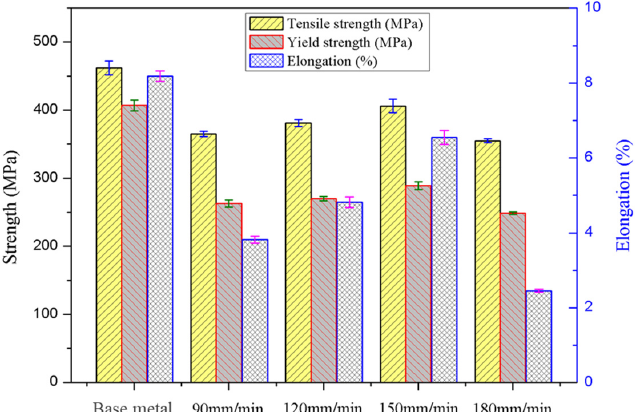
Figure 7. Tensile properties of FSW joints produced at various welding speeds and base material.